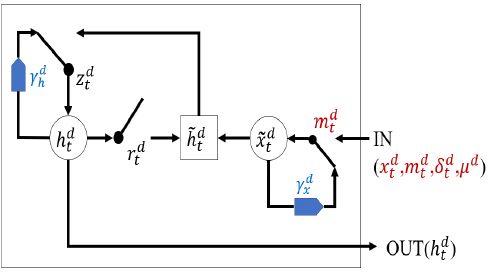
Figure 3. VS-GRU (symbol in red refers to input and symbol in blue refers to decay